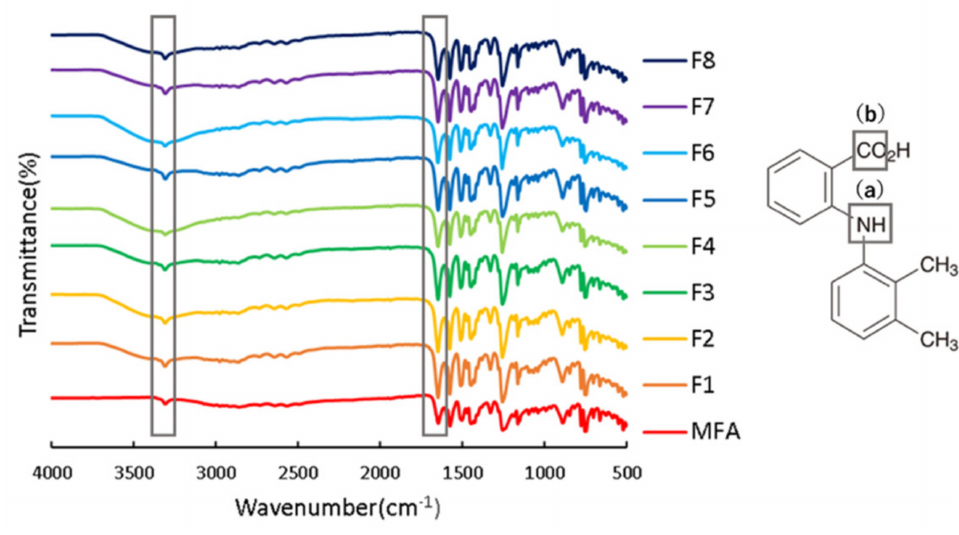
Figure 5. FT-IR spectra of various